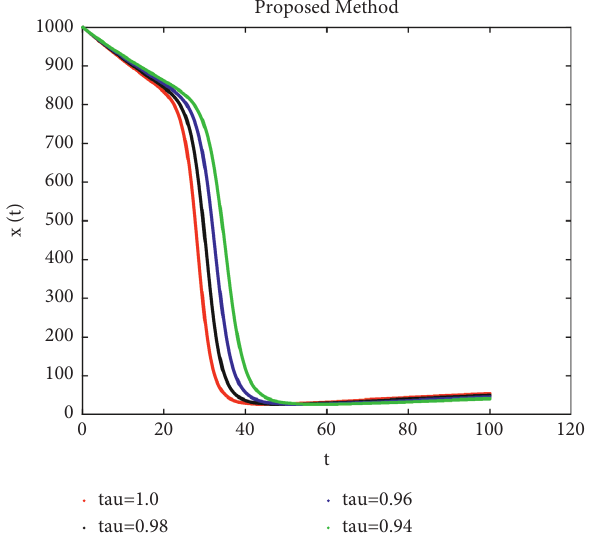
Figure 1: Dynamical behavior of concentration of uninfected (susceptible) cells at α � 1 and various fractal order under power law kernel.